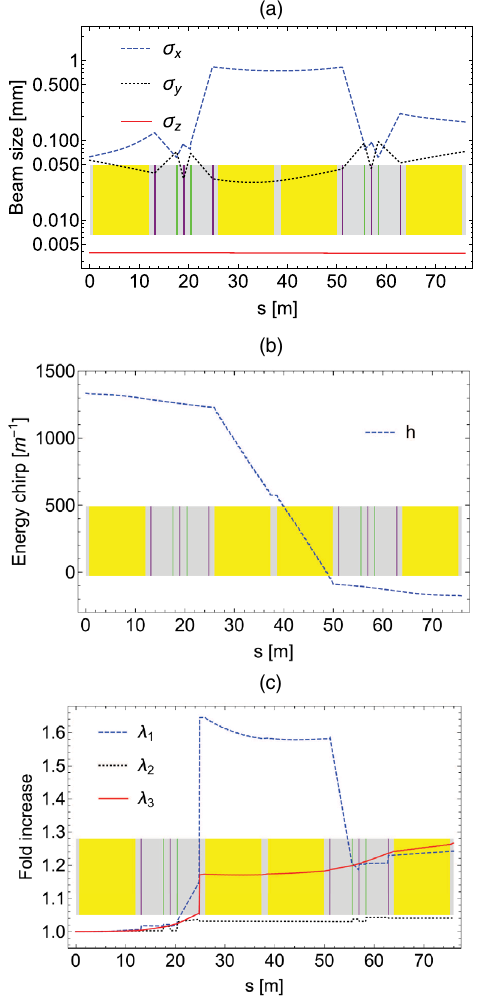
FIG. 15. Longitudinal phase space at the entrance (blue) and exit of the TCAV-based dechirper at 1 GeV with optimized input Twiss parameters for 0 (red) and 100 pC (green)